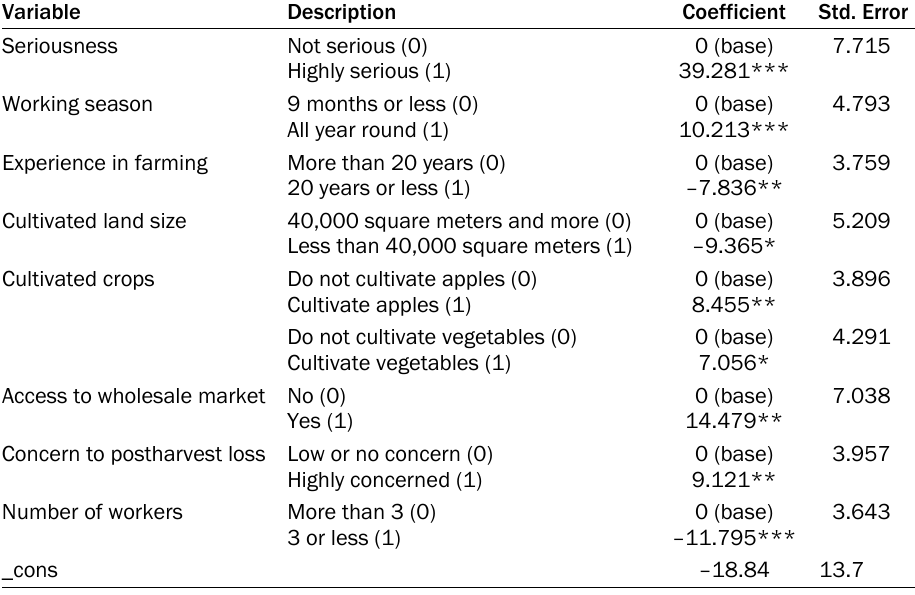
Table 4. Model Estimation Results for the Interval Regression Analysis